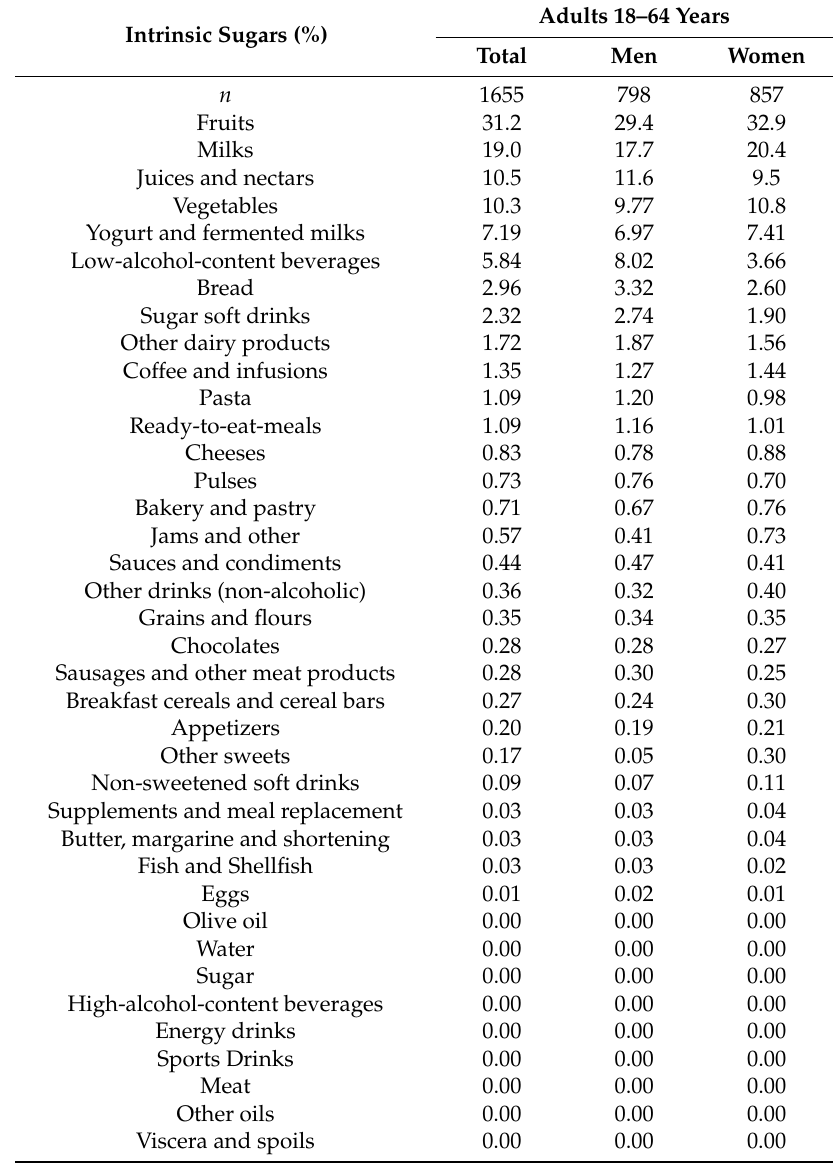
Table 9. Dietary sources of intrinsic sugars (%) from food and beverage subgroups in the ANIBES Study Spanish population aged 18–64 years: